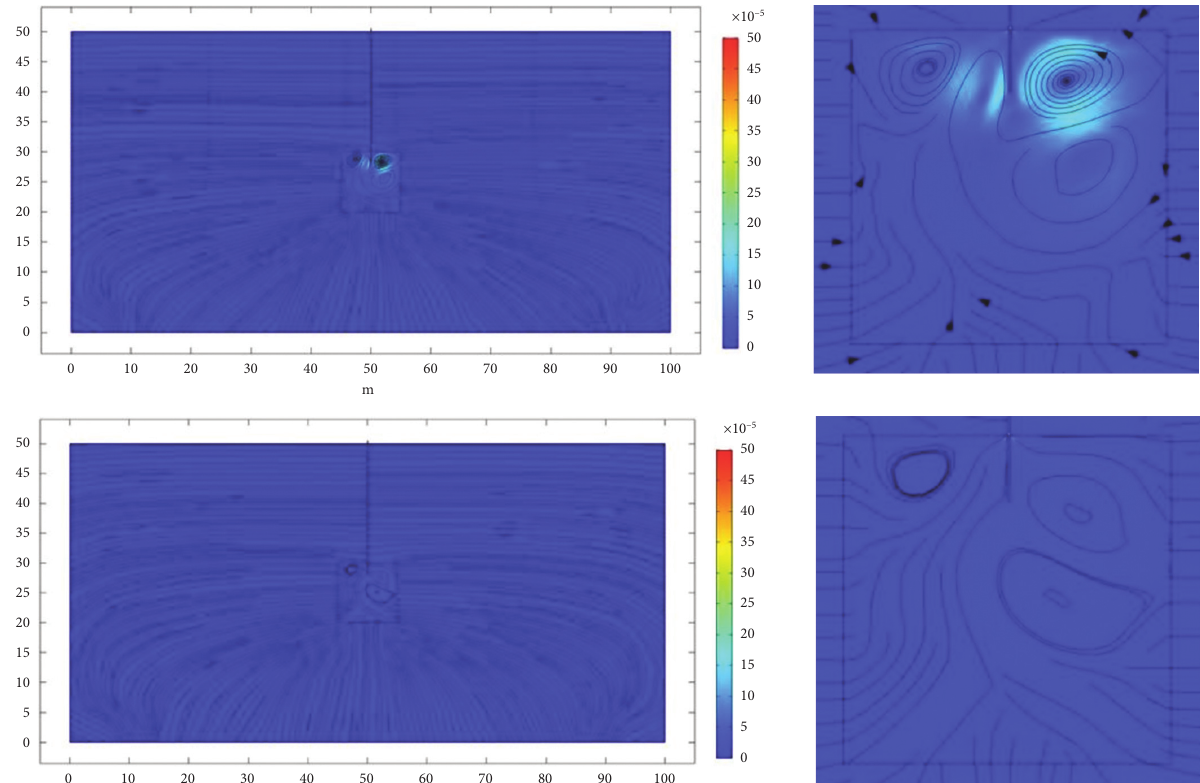
Figure 4: Comparison of two dimensional velocity field distribution in different periods.